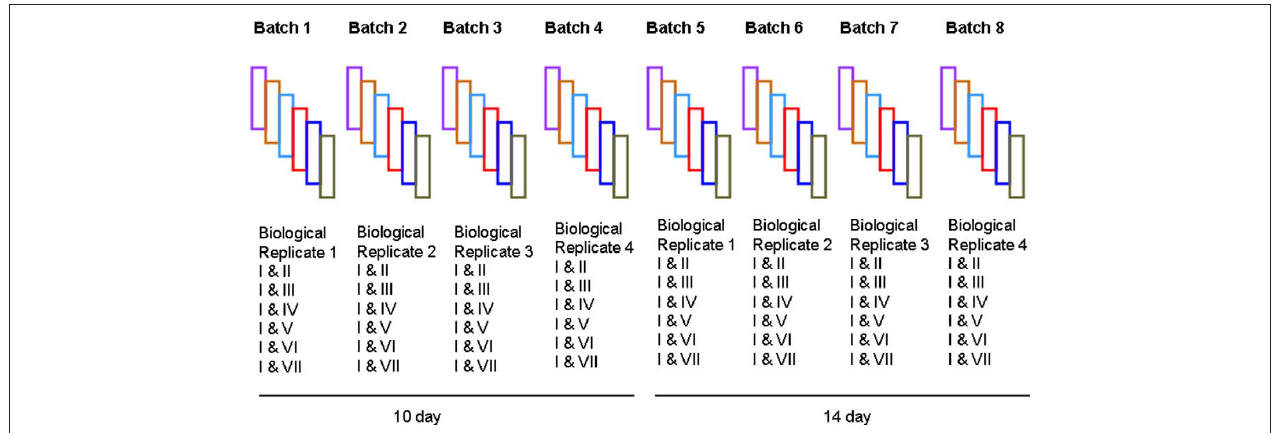
Figure 2 | Batch structure of microarrays. Microarrays were run in eight batches. Each batch comprised of one of the four biological replicates belonging to 12 comparisons depicted in Figure 1. Fly treatment, RNA isolation, labeling, hybridization, and scanning were carried out separately for each of the eight